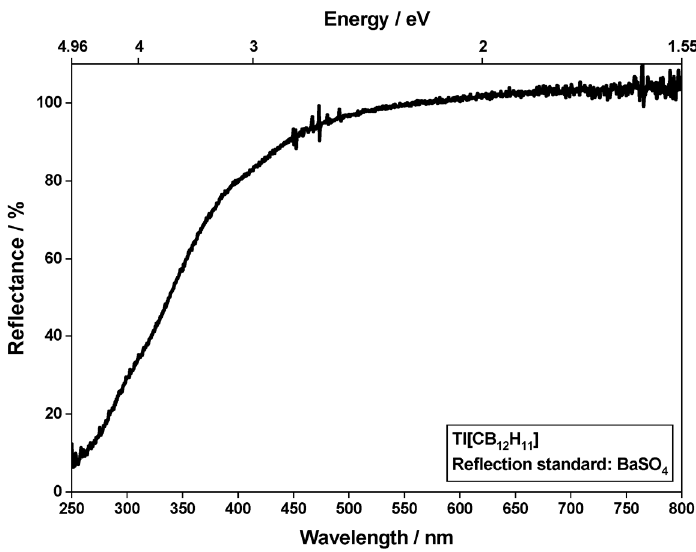
Figure 10. Reflection spectrum of a microcrystalline Tl[CB 11 H 12 ] sample versus the white reflectance standard Ba[SO 4 ].